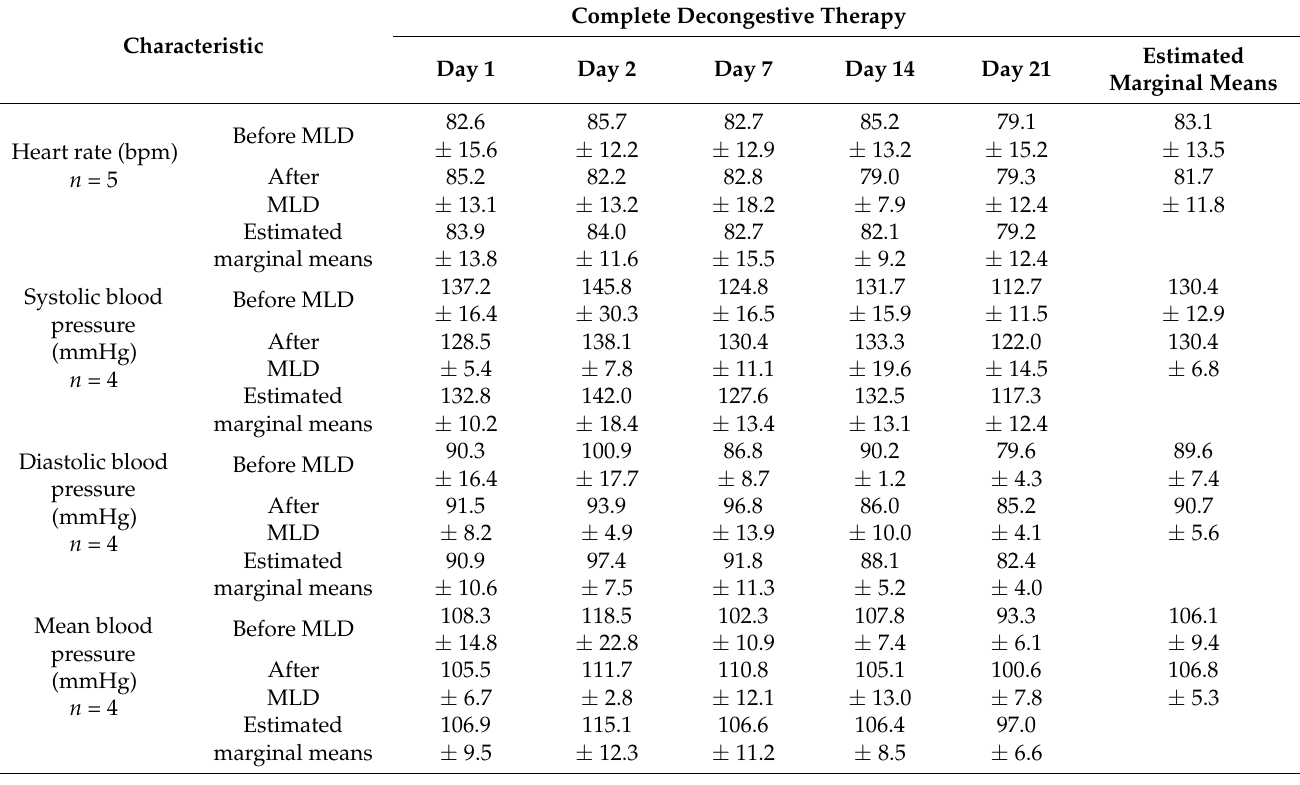
Table 2. Changes in resting hemodynamic parameters (baseline values) during three weeks of complete decongestive therapy, pre- vs. post-manual lymphatic drainage (MLD). The data are displayed as means ± standard deviation.